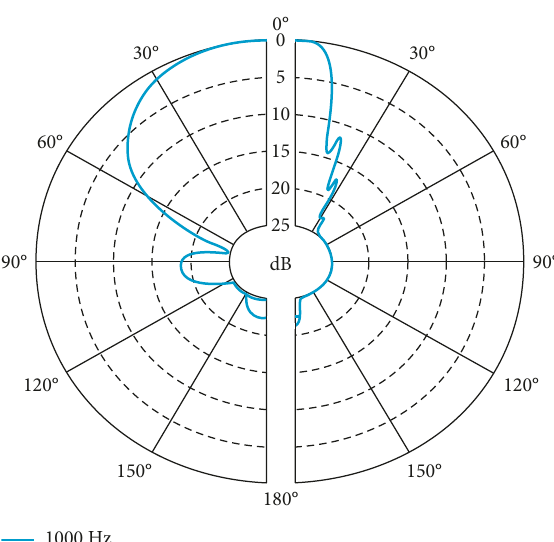
Figure 3: Microphone’s polar diagram.